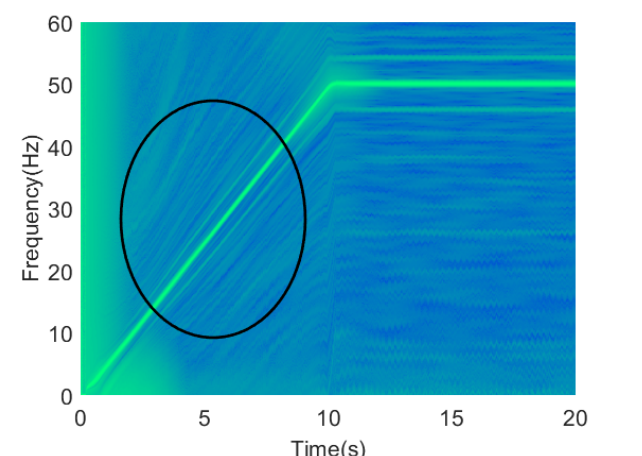
Figure 4. Time-frequency distribution of the stator current. The black circle marks the area analyzed.